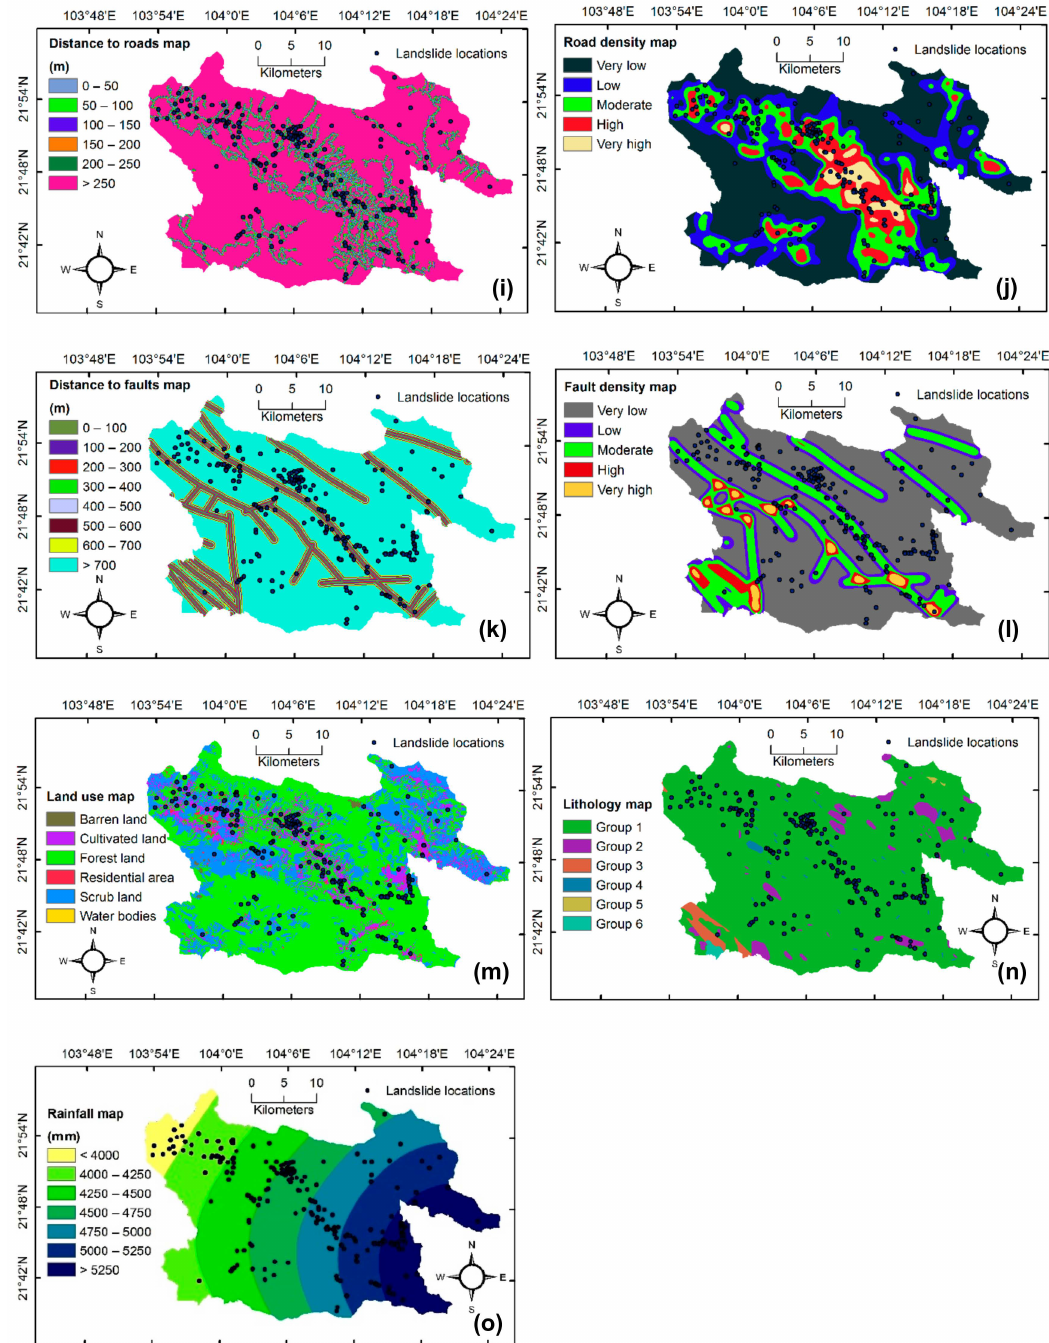
Figure 2. Maps of the landslide a ff ecting parameters: ( a ) slope map, ( b ) aspect map, ( c ) profile curvature map, ( d ) curvature map, ( e ) plan curvature map, ( f ) elevation, ( g ) distance to rivers map, ( h ) river density map, ( i ) distance to roads map, ( j ) road density map, ( k ) distance to faults map, ( l ) fault density map, ( m ) land use map, ( n ) lithology map, and ( o ) rainfall